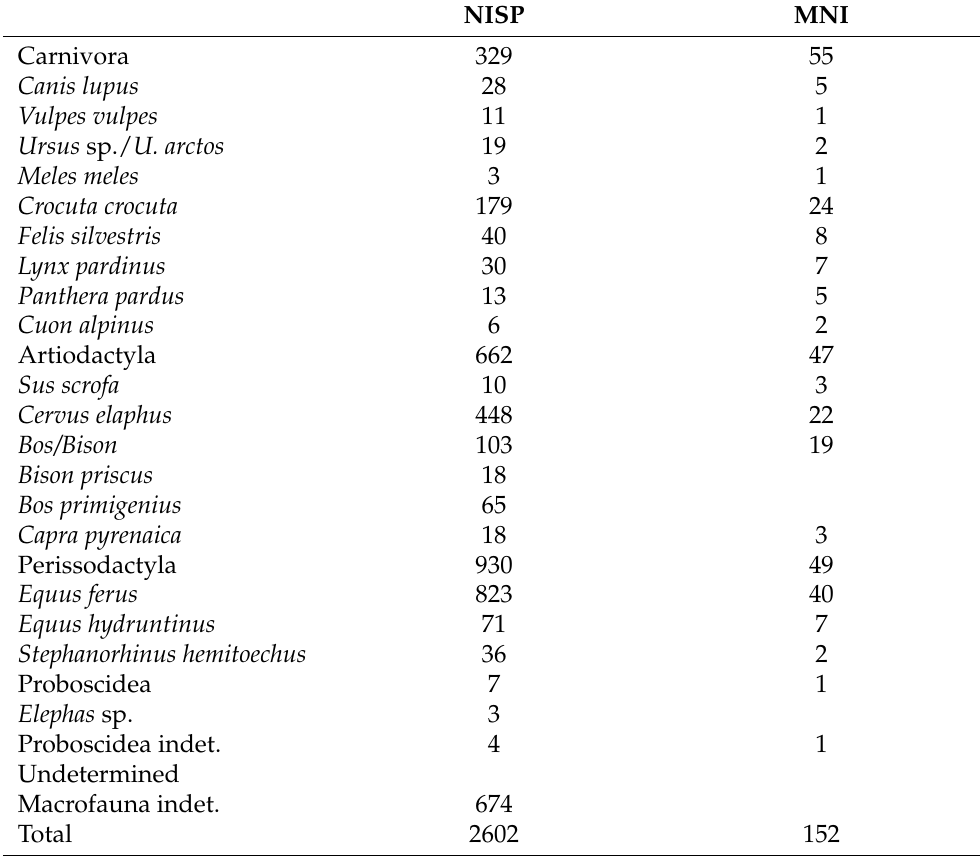
Table 3. Number of Identified Specimens (NISP) and Minimum Number of Individuals (MNI) of the large mammals identified at